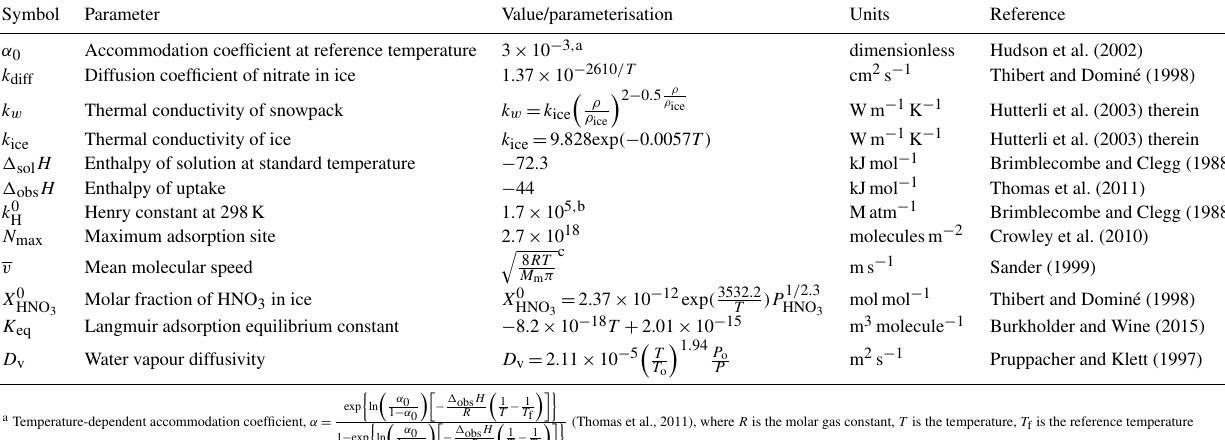
Table B1. Parameterisation for HNO 3 .